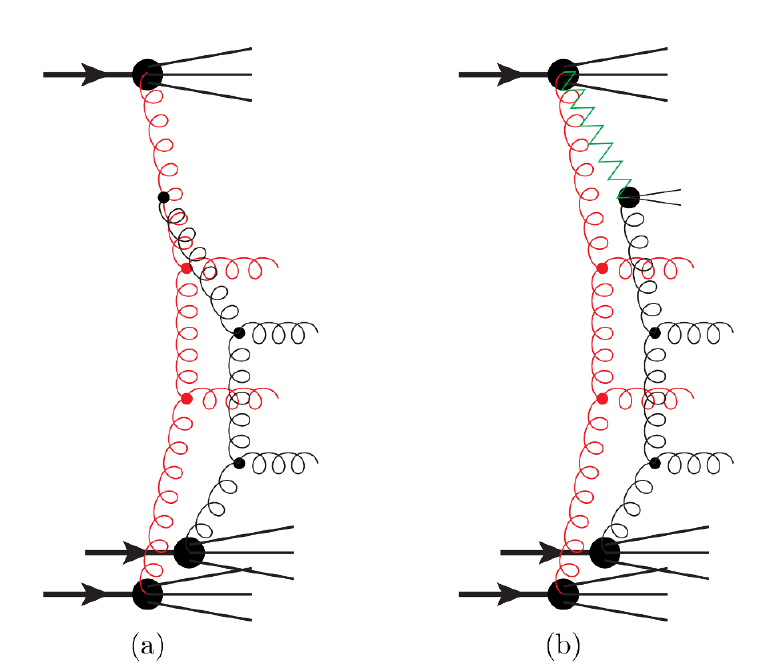
Figure 3 . A schematic picture (cf. (cid:12)gure 2) of multiple scattering between one projectile and two target nucleons (e.g. in a pd collisions). In (a) the second interaction is directly colour connected to the (cid:12)rst one, while in (b) the second nucleon is only di(cid:11)ractively excited by a Pomeron exchange. Both cases give rise to (cid:12)nal string con(cid:12)gurations that will contribute in the same way to the (cid:12)nal state hadron